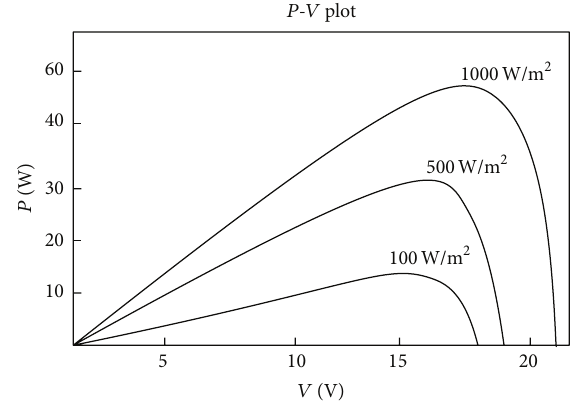
Figure 7: Characteristics curve for BP MSX 60W module. 𝑃 - 𝑉 curves of BP MSX 60 W for different radiations.